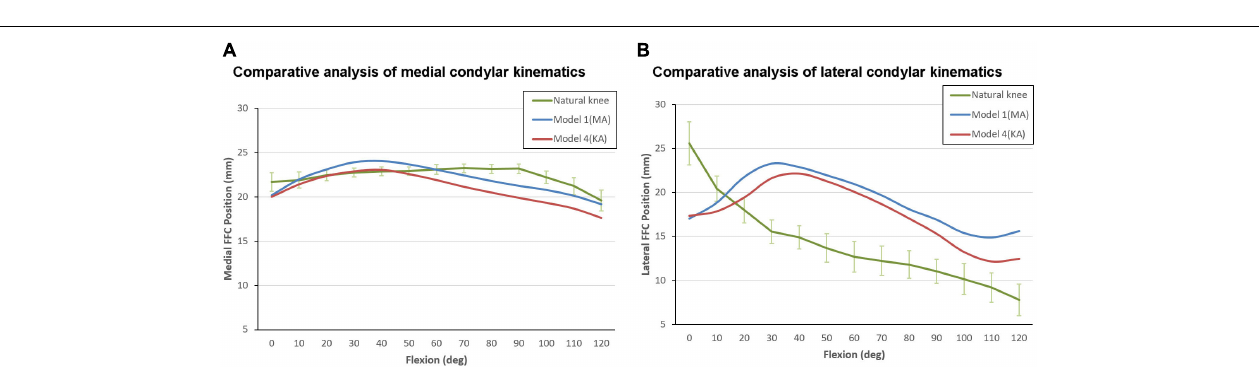
FIGURE 6 | Kinematic comparison of different joint line inclinations showing anterioposterior translation of the medial (A) and lateral (B) FFCs coupled with knee flexion. The “0” value on the vertical axis represents the initial position of the model before mechanical equilibrium, positive values indicate forward positioning of the FFCs, and negative values indicate backward positioning of the FFCs.